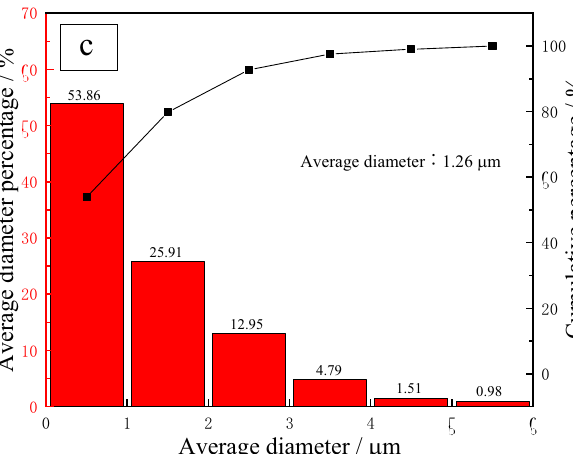
inclusions in the WCu composites microalloyed with Fe, Ni, and Mn are 0.25, 1.09, and 0.42%, respectively. These results are consistent with the variation of the tungsten and oxygen contents in Table 1 . Figure 5 shows the W particle distributions in the microstructure of the microalloyed WCu composites. The average diameters of W particles in the WCu composites microalloyed with Fe, Ni, and Mn are 3.47, 4.88, and 1.26 μ m, respectively. Mn clearly decreases the size of tungsten particles,